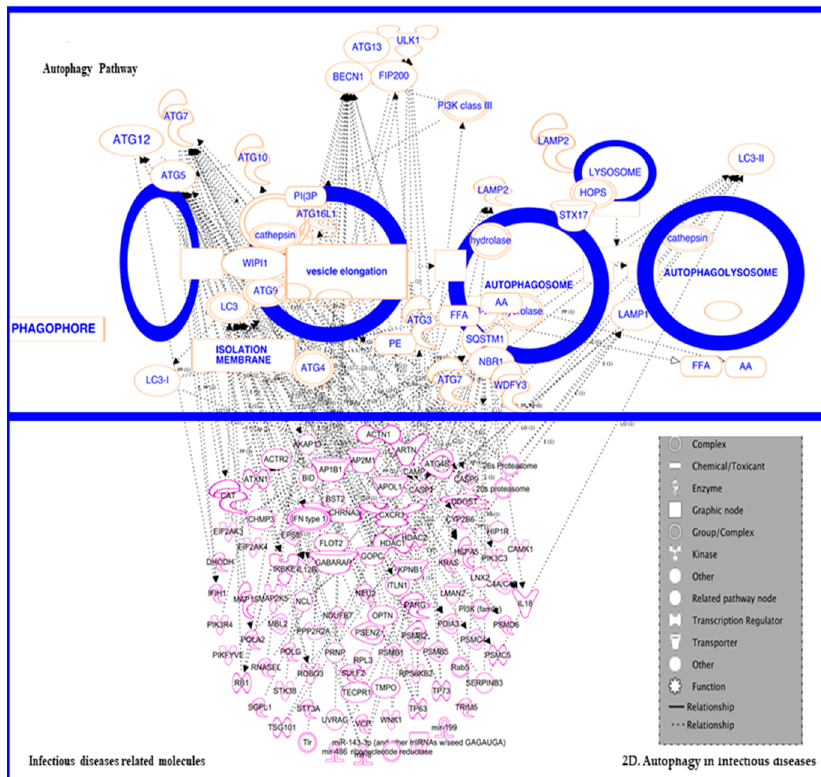
Figure 2. The interconnection of autophagy-related proteins in ( A ) neurological diseases, ( B ) cancer, ( C ) renal disease, and ( D ) infectious diseases. All these figures represent the critical events and key molecules which are connected between autophagy and diseases. In panel 2A, the autophagy proteins, namely LC3-II, BECN1, ATG 13 complex, LAMP2, ATG10, ATG12, ATG7, and ATG5, have been predicted to interlink with neurological diseases-related molecules, such as AMBRA, GABARAPL, VPS18, VPS39, VPS33A, OPTN, KEAP1, Rab5, TRIM55, TRIM33, AKT1S1, APOL1, AIM2, MAP1B, and others. In panel 2B, autophagy proteins, namely LC3-II, BECN1, ATG 13 complex, LAMP2, ATG10, ATG12, ATG7, and ATG5, have been predicted to interlink with cancer-related molecules, such as APOBEC3B, VPS41, TRIM55, TRIM16, AKT1S1, APOL1, APOL6, ATG14, CNN3, MAP1B, ROBO3, SYNPO2, PUM2, SAFB2, and others. In panel 2C, autophagy proteins, namely LC3-II, BECN1, renal disease-related molecules, such as APOBEC3B, TAB3, VPS33A, TRIM16, WDR41, WIP12, STK4, TFEB, SNAPC4, PIK3C2A, PINK1, MDK, OPTN, KEAP1, FNIP-1, and others. In panel 2D,